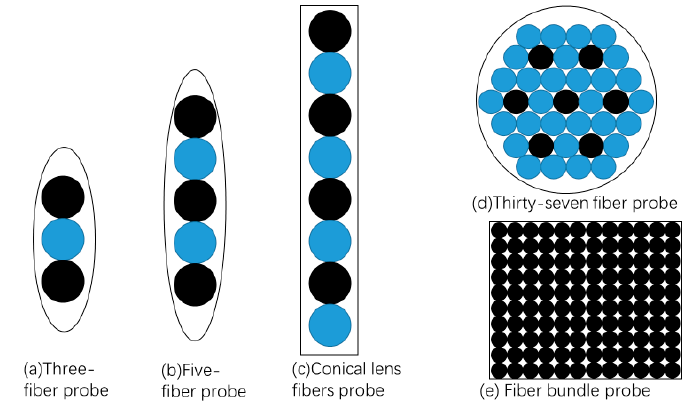
Figure 1. Typical structures of optical fiber probes for particle velocity measurement reported by previous researches: blue circles denote light emission fibers; black circles denote light receiving fibers. ( a ) Three-fiber probe; ( b ) five-fiber probe; ( c ) conical lens fiber probe; ( d ) thirty-seven fiber probe; ( e ) fiber bundle probe.